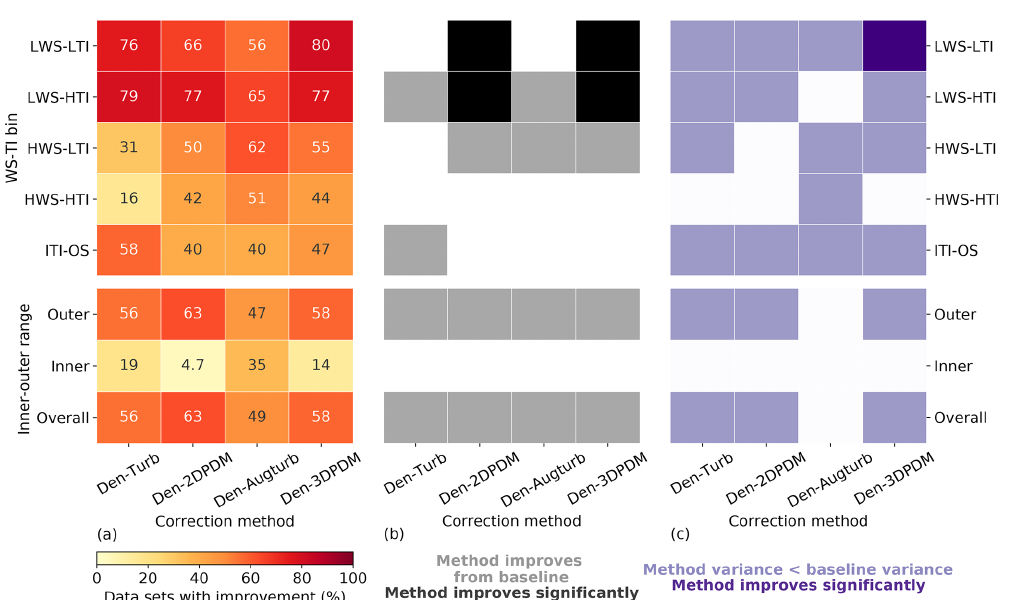
Figure D1. As in Fig. 10, but after removing the submissions with a method’s substantial improvement upon the baseline method (top 10 percentile of the absolute NME differences) as well as using smaller alphas based on the Bonferroni correction (the bin number is two